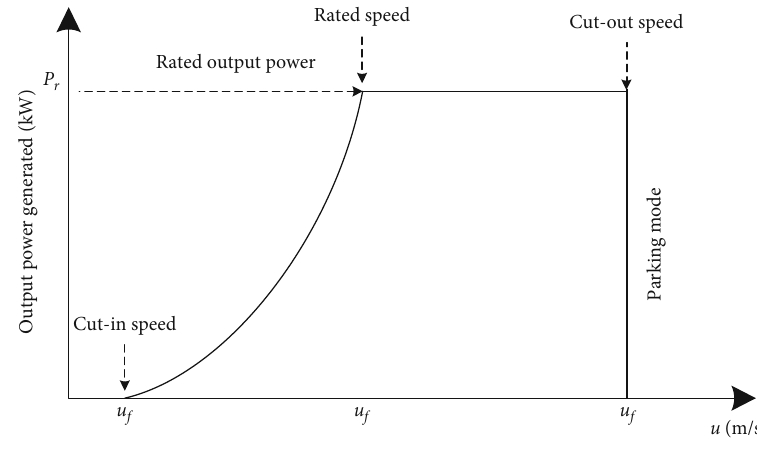
Figure 2: Power characteristic curve of a